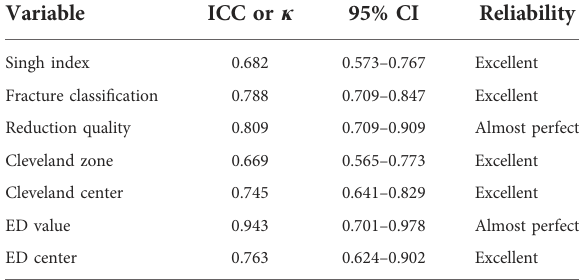
TABLE 3 Reliability between two independent observers for measuring